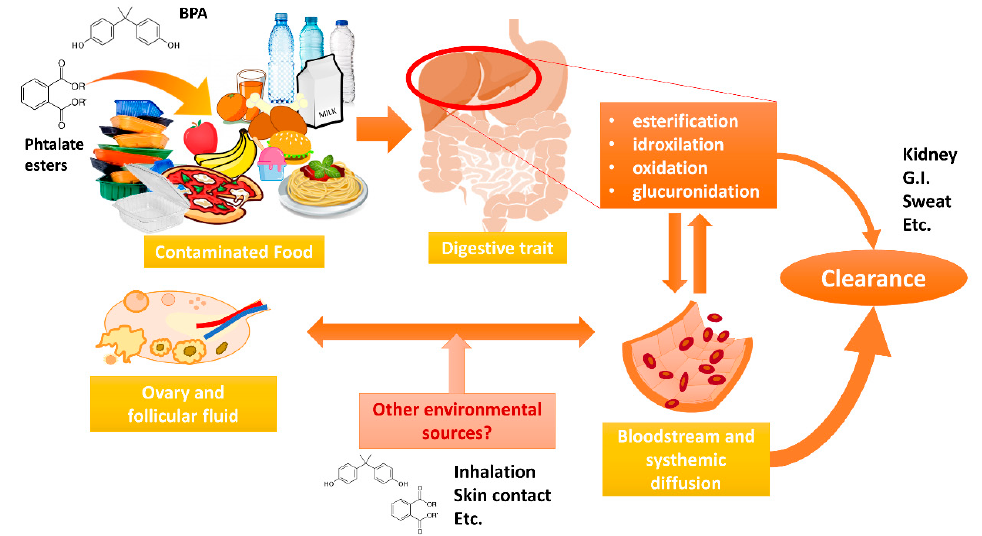
Figure 5. Exposure, metabolism, body circulation and elimination routes of BPA and phthalate esters. Data on measurement of phthalate esters and BPA in human follicular fluid are scarce. Ikezuki et al. (2002) measured BPA levels in women from healthy women, including several who underwent in vitro fertilization (IVF) [23]. In particular, the authors detected an average BPA level of 2.4 ± 0.8 ng / mL from 36 follicular fluids. This is in contrast with another report that involved follicular fluids from